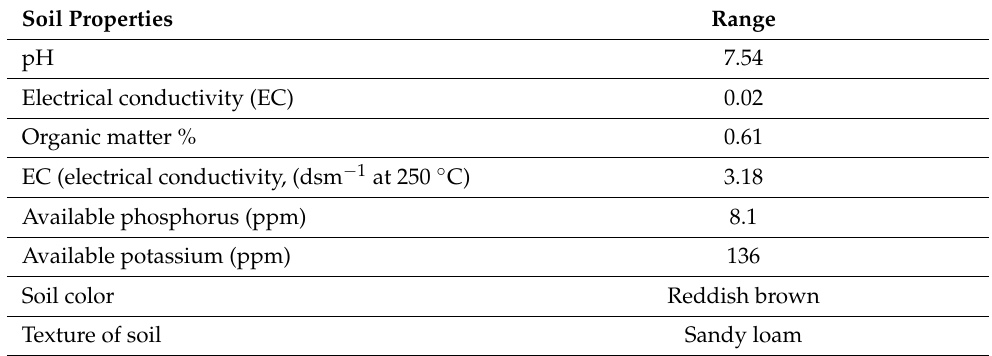
Table 1. Soil physiochemical properties before sowing of barley